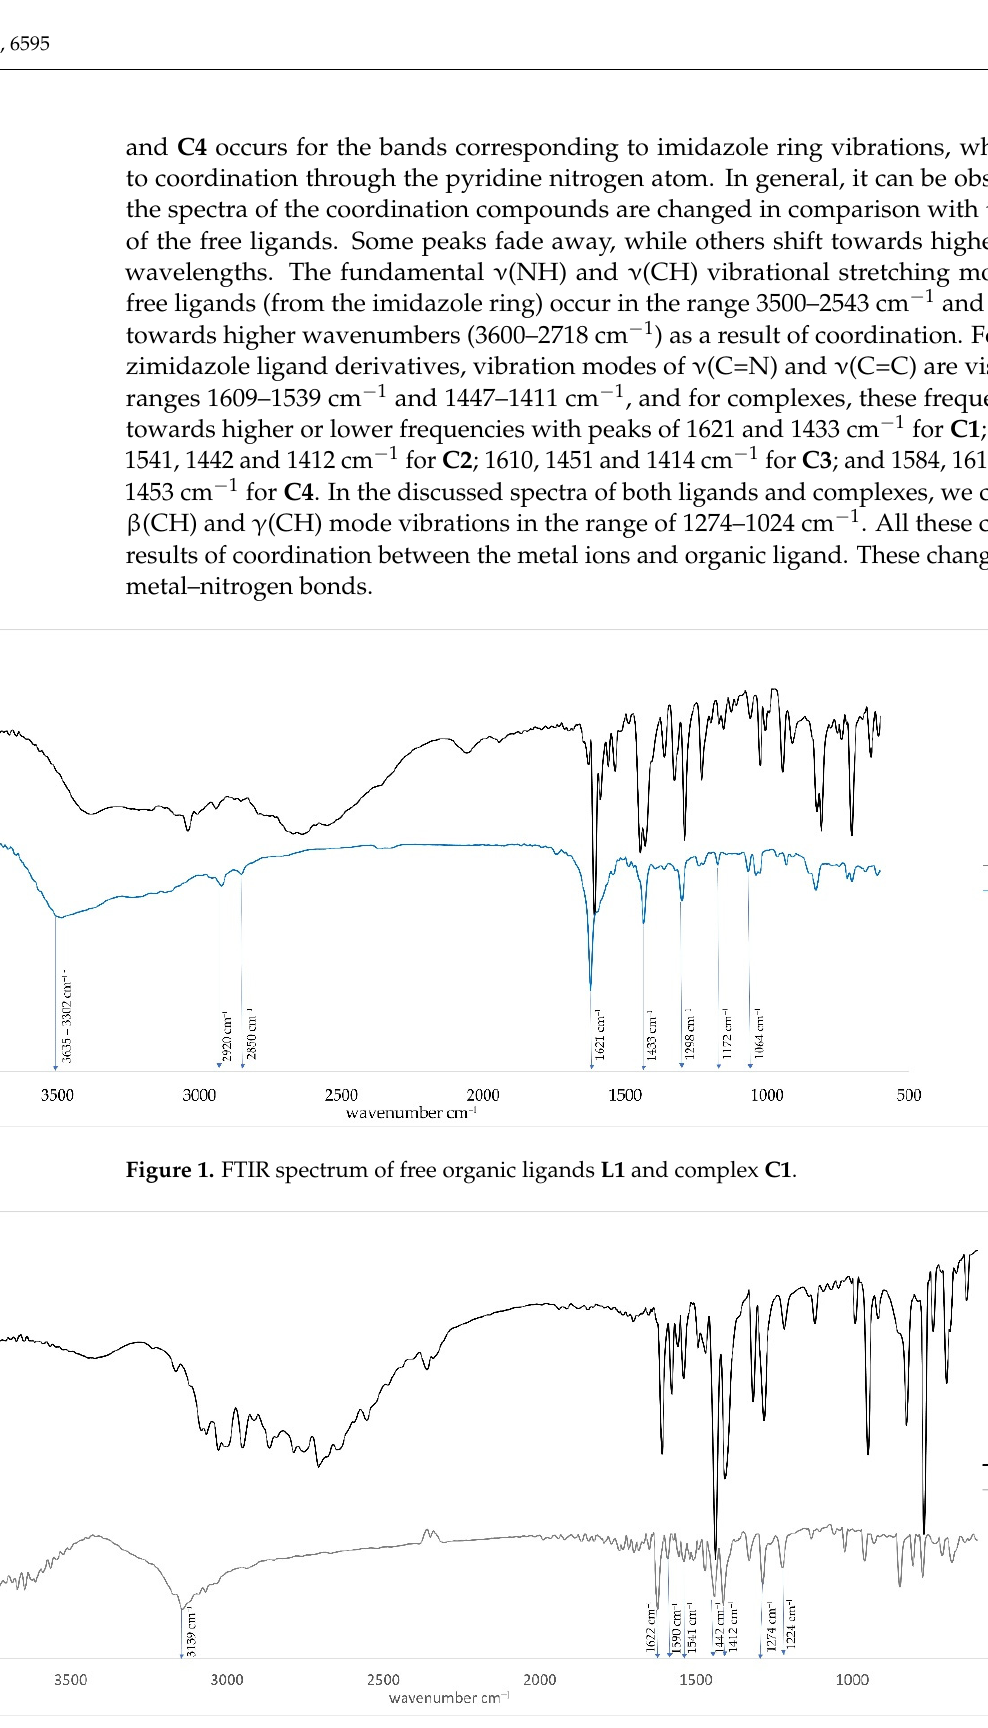
Figure 2. FTIR spectrum of free organic ligands L2 and complex C2.